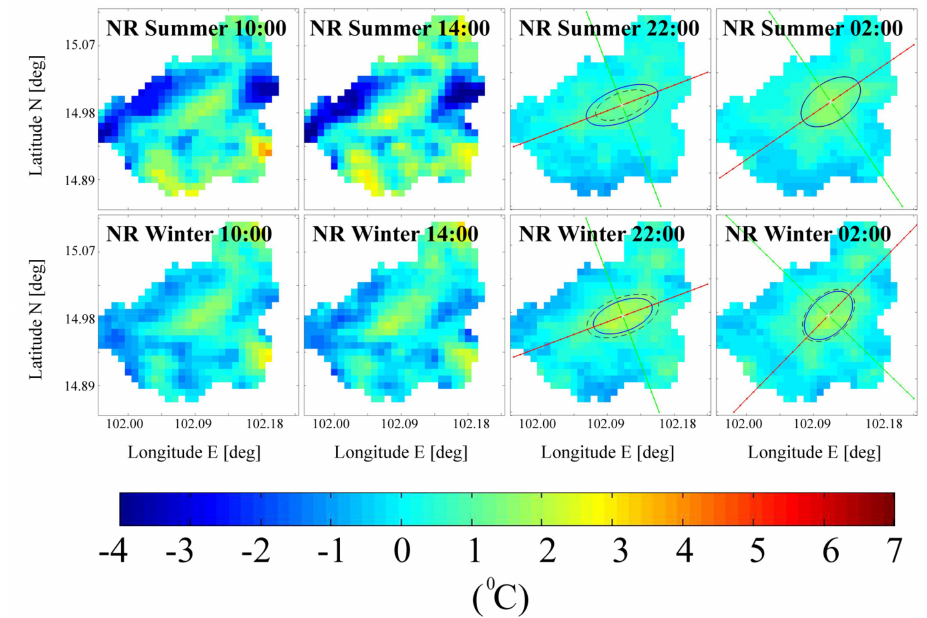
Figure 5. SUHI ( ◦ C) and Gaussian fitting during 2014 for Bangkok (BG), Chiang Mai (CM), and Nakhon Ratchasima (NR) for summer and winter, considering the diurnal variation at 10:00, 14:00, 22:00, and 02:00.